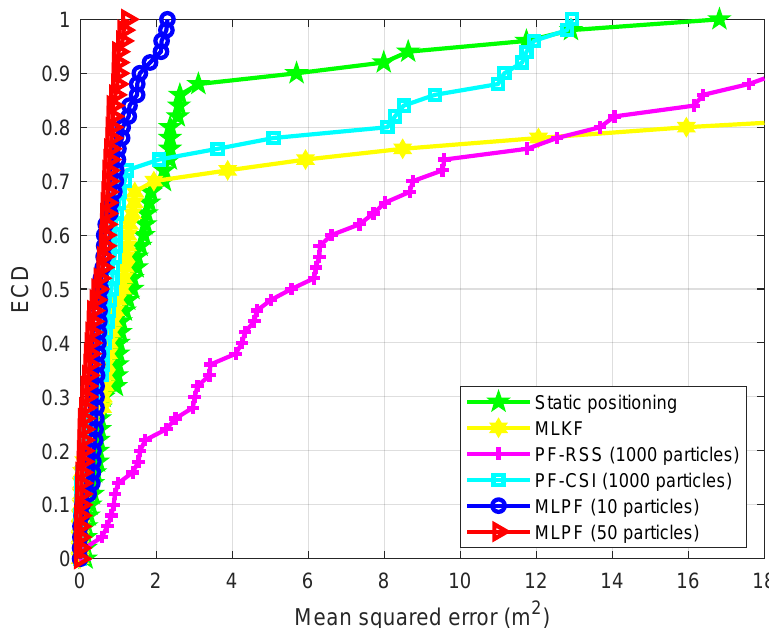
Figure 7. Positioning ECD (office